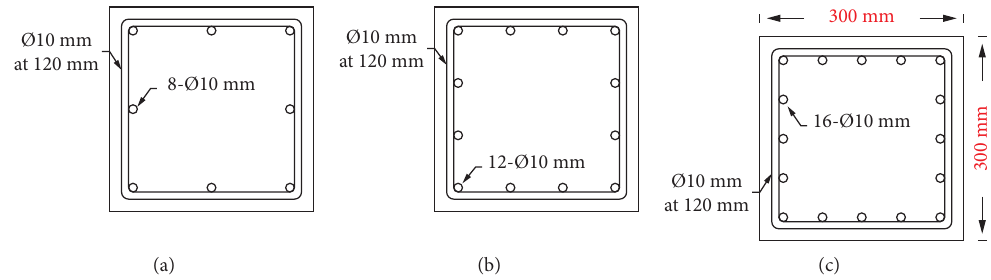
Figure 5: Reinforcement details of the tested beams. (a) ρ � 0.007. (b) ρ � 0.01. (c) ρ �